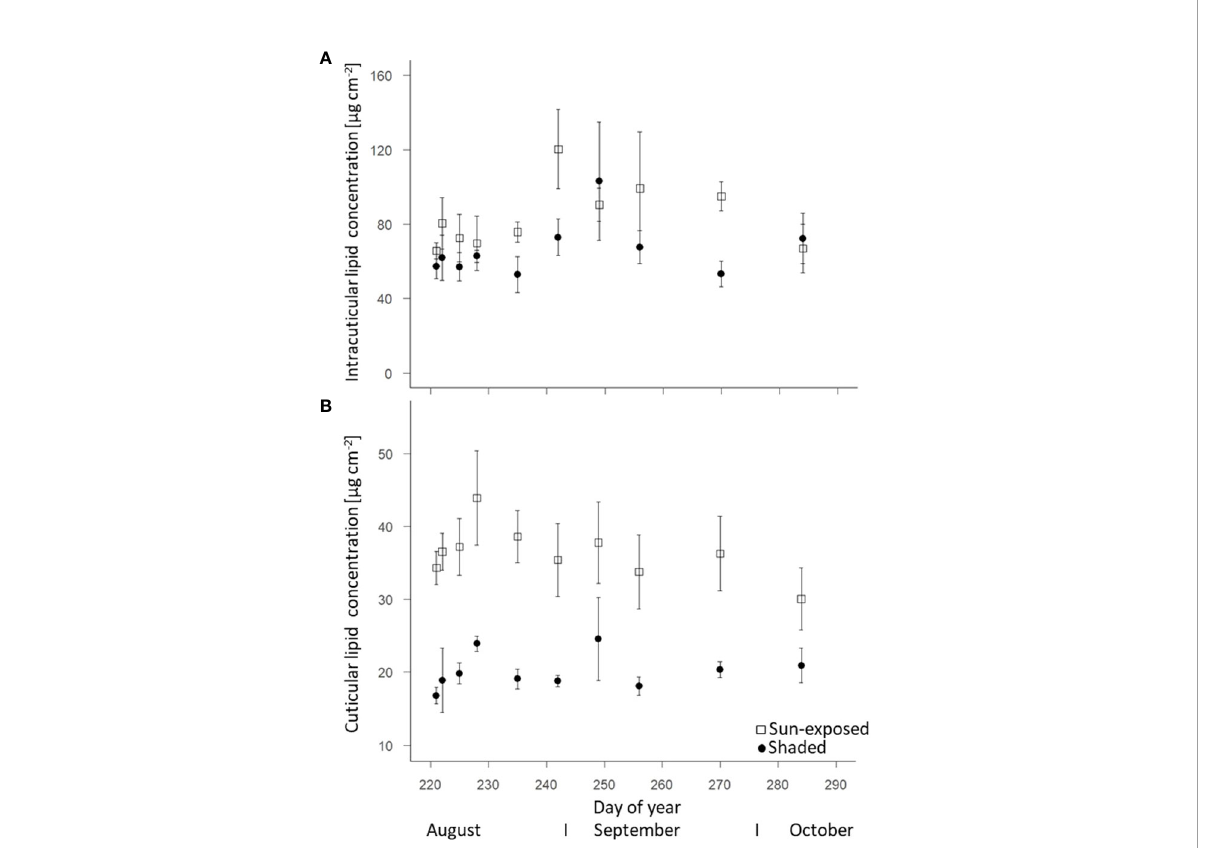
FIGURE 3 Change of intracuticular (A) and cuticular (B) lipid concentrations of sun-exposed and shaded leaves during late growing season ( fi eld replicates n = 4, error bars indicate